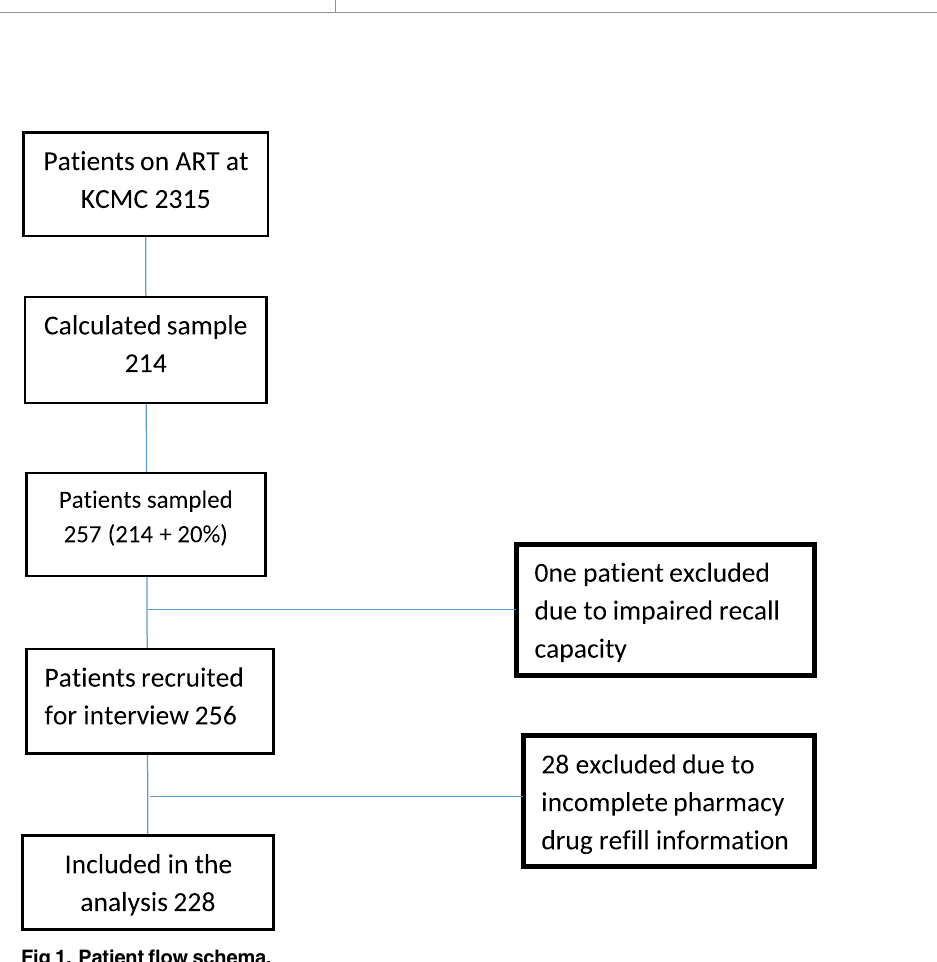
Fig 1. Patient flow